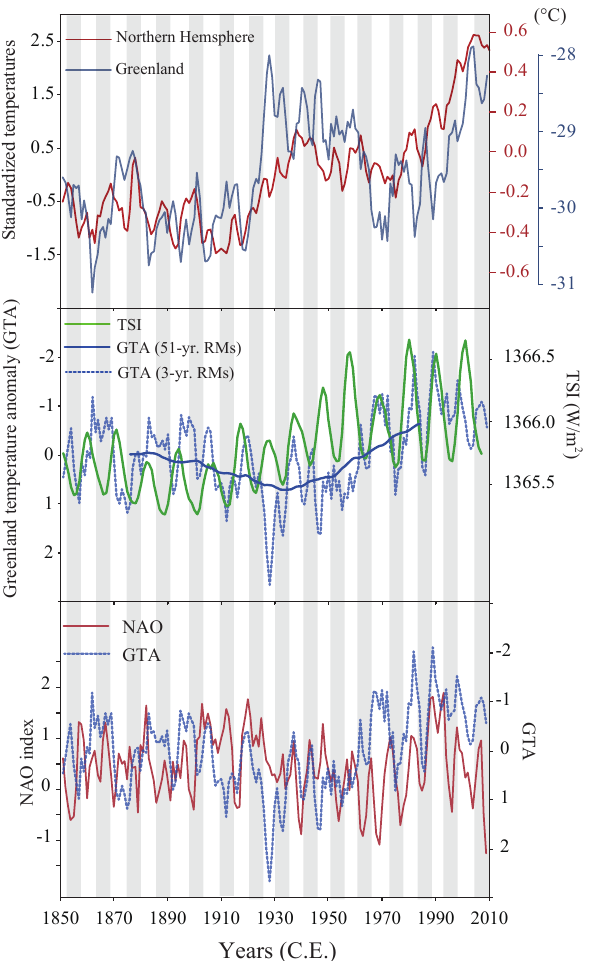
Fig. 1. Climate records for the 1850–2010 period. Top panel: annual average Greenland Summit temperature (Box et al., 2009) and an- nual average NH temperature (HadCRUT3) (Brohan et al., 2006). Twenty-year root mean squared errors (RMSE) for the Summit tem- perature are estimated to be less than 1.6 ◦ C (Box et al., 2009). Mid- dle panel: Greenland temperature anomaly (GTA [ G-NH ] ) vs. TSI with background (Wang et al., 2005). Bottom panel: GTA [ G − NH ] vs. winter NAO (DJFM; CRU) (Jones et al., 1997; Osborn, 2011). All time series are smoothed by 3-yr RMs except the Greenland temperature in 51-yr RMs. Shaded areas are periods of low solar activity. Note that the axis for GTA is reversed.